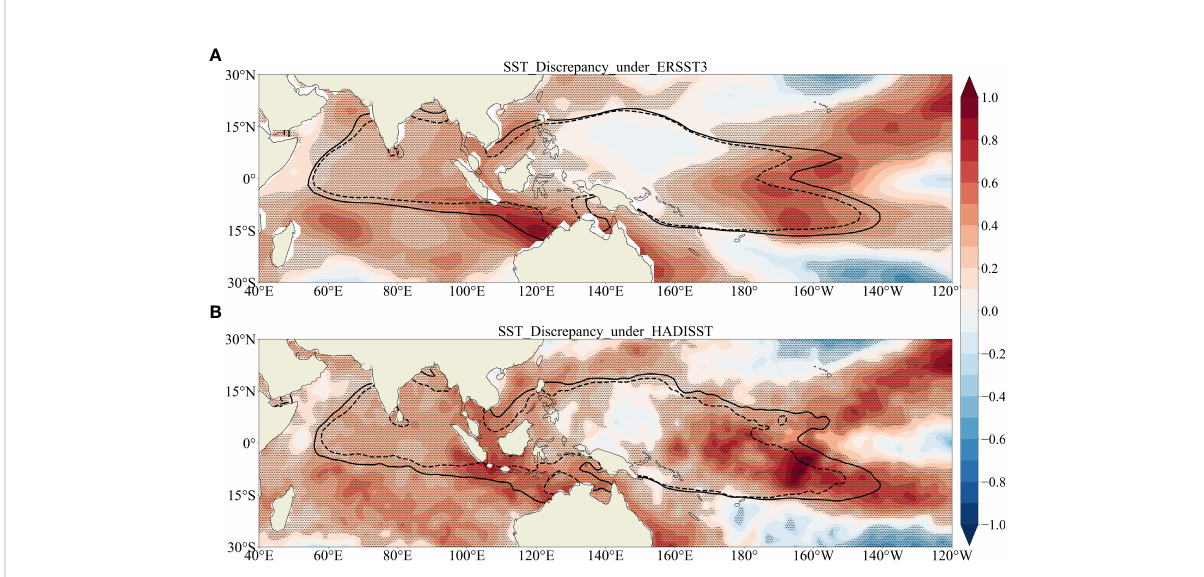
FIGURE 1 Characteristic sea-surface temperature (SST) discrepancy (shading) with 28°C SST isotherm (line) under IPWP warm and cold events for (A) ERSST3 and (B) HadISST. The solid and dashed lines show the 28°C SST isotherm under IPWP warm events and cold events, respectively. The dotted represent signi fi cance at the 0.05